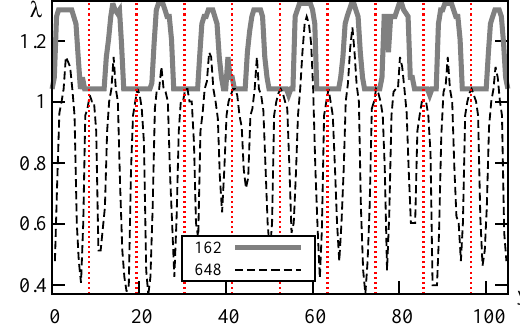
Figure 5. The irregularity index computed in 4-year sliding win- dows for synthetic data averaged over 162 (solid gray) and 648 (dashed black) days ( m =1). Model parameters: a =0.8, h =0.4, k =0.0, and c =1.7. Red dashed vertical lines at solar sunspot